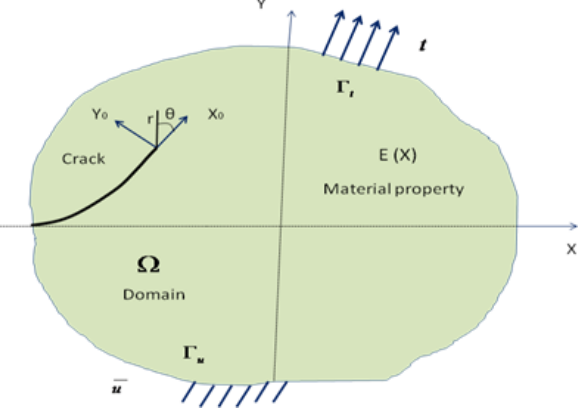
Figure 1: An arbitrary orthotropic body with crack, subjected to traction t and displacement u , having global Cartesian co-ordinate ( X, Y ), local polar co-ordinate ( r, θ